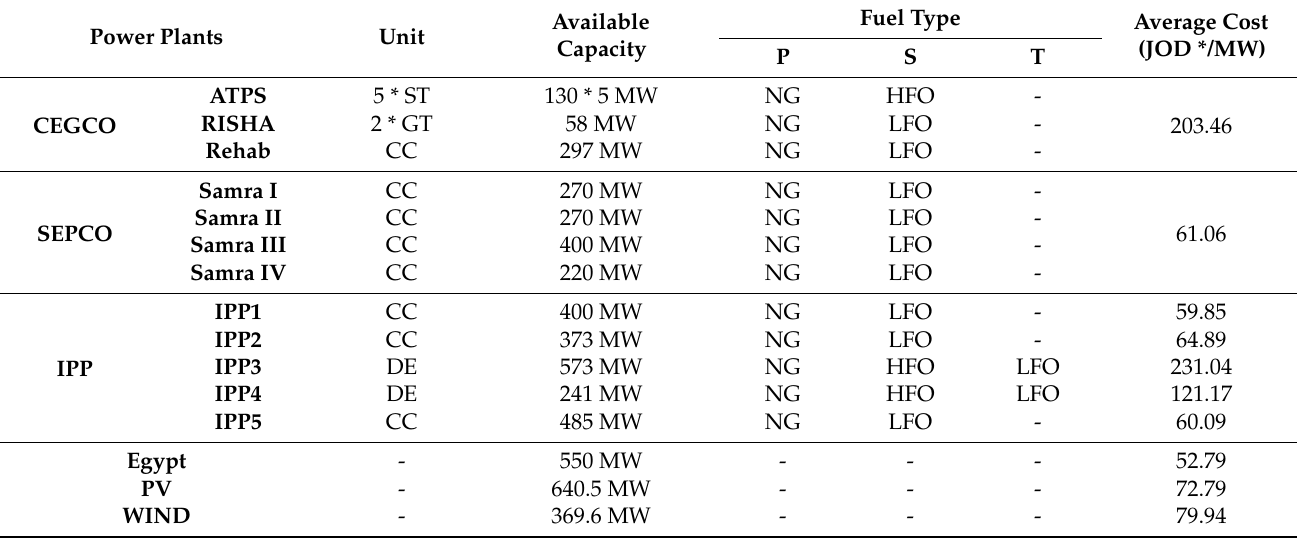
Table 2. Jordanian power plants—2019.